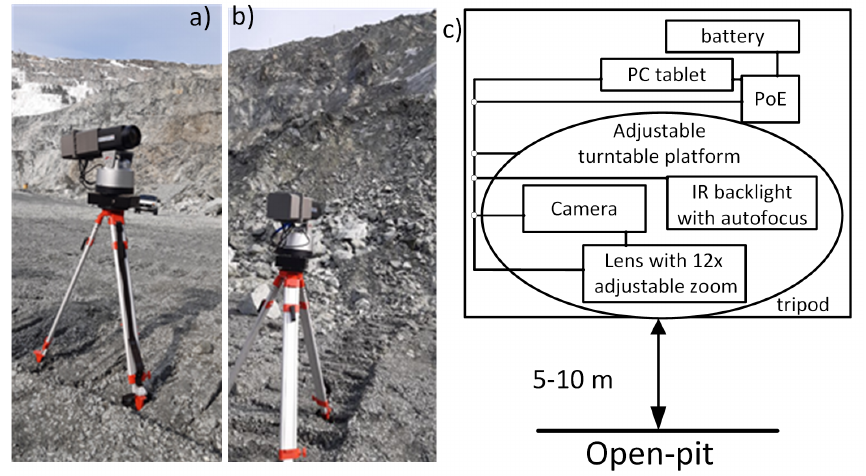
Figure 2. Photo of the developed system ( a ); image of system at the open pit background ( b ) and scheme of the system ( c